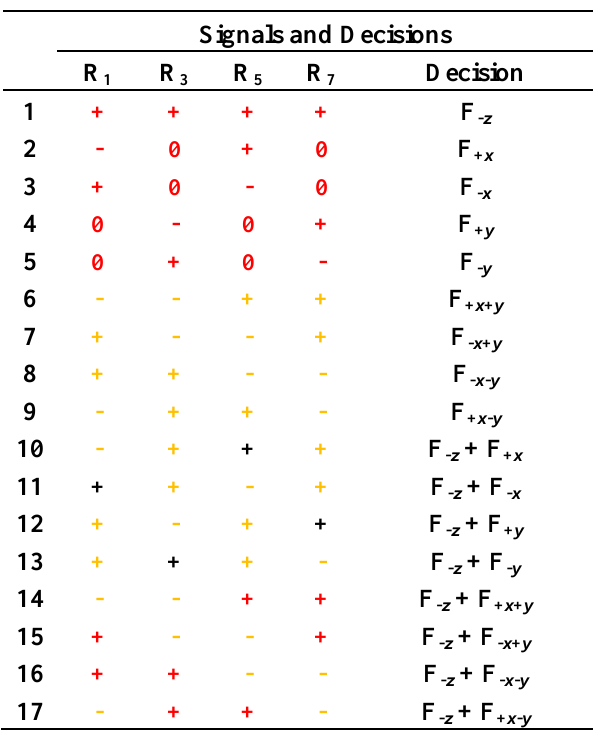
Table 2. The signal combination of all possible arrangements of the strain gauges and the predicted